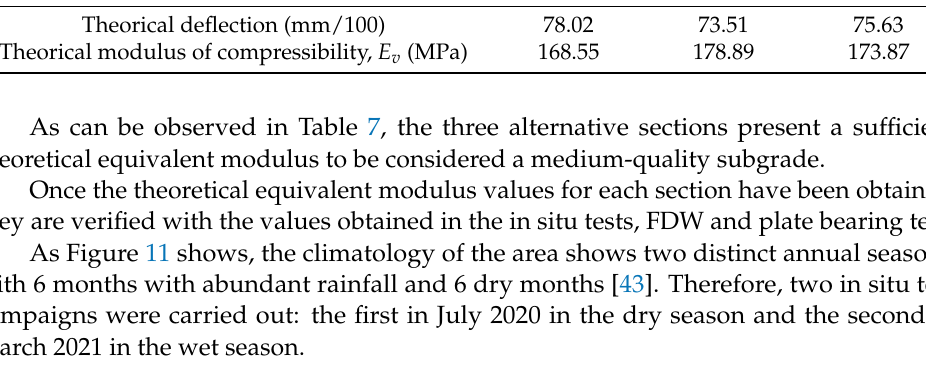
Table 7. Theorical deflection and modulus of compressibility obtained in Everstress 5.0. Everstress Results AS-1 AS-2 AS-3 Theorical deflection (mm/100) Theorical modulus of compressibility, E v (MPa)